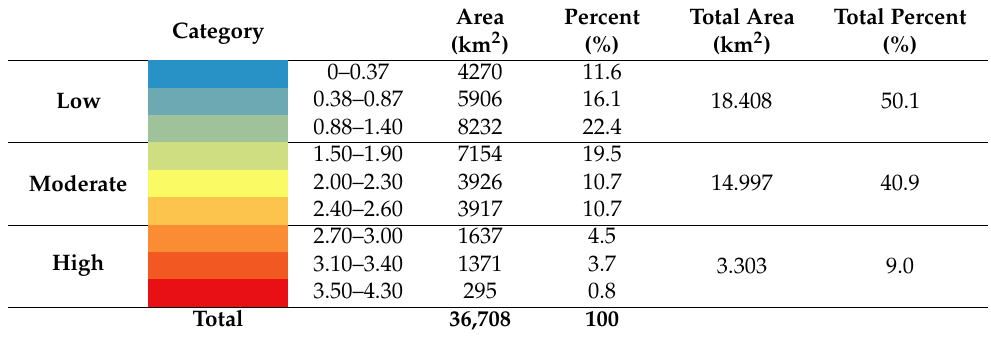
Table 3. The proposed class boundaries (low, moderate, high) of the overlapping areas of non- indigenous and critically endangered freshwater fish species, the actual areas, and the total percentage for each